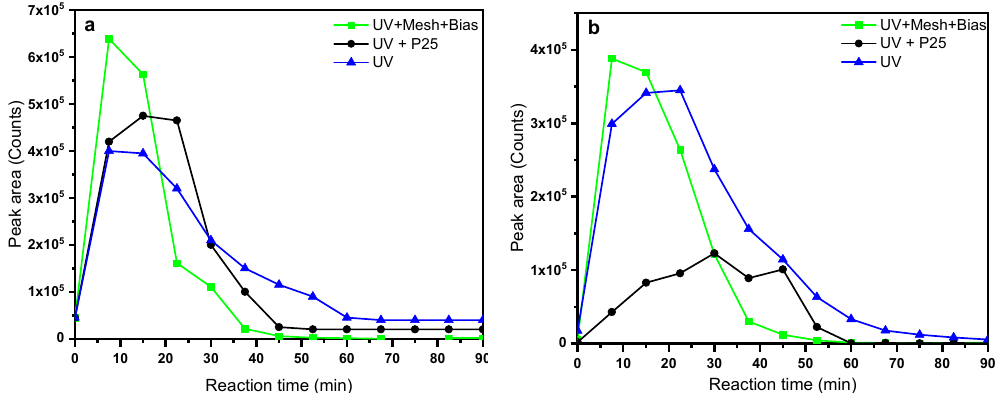
Figure 4. Time-resolved profiles of TP252 ( a ) and TP266 ( b ) of carbamazepine obtained by all the investigated processes.